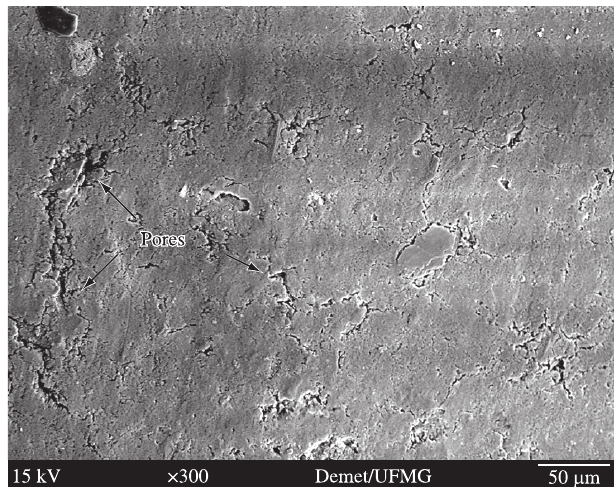
Figure 6. Interaction effect plot for flexural strength, fraction of steatite and compaction.